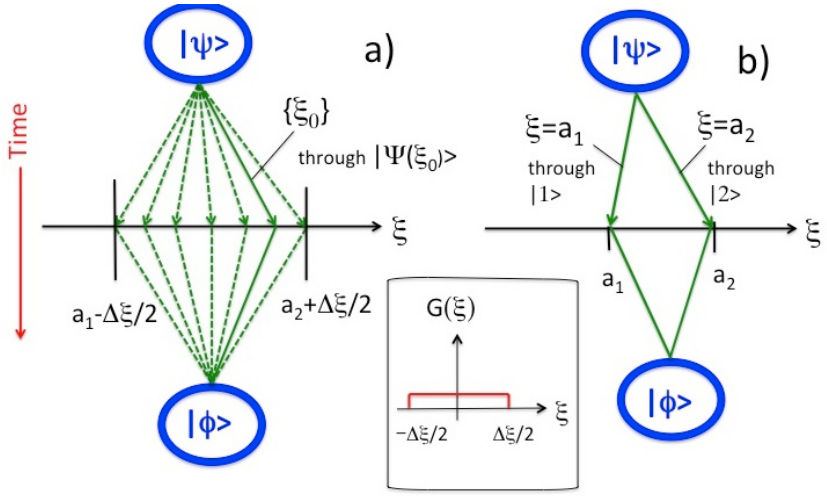
Figure 2. ( a ) Schematic diagram showing a continuum of real pathways produced in a measurement of an operator ˆ A with eigenvalues a 1 < a 2 . A pathway connects three observable events: preparation in | ψ (cid:105) at t = 0, obtaining a meter reading ξ 0 at t = T /2 and finding the system in | φ (cid:105) at t = T . If a reading ξ 0 is obtained, the system “passes” through the state | Ψ ( ξ 0 ) (cid:105) in Equation (14). For G ( ξ ) in Equation (13) (see the inset), the pointer readings are contained in the interval [ a 1 − ∆ ξ /2, a 2 + ∆ ξ /2 ] ; ( b ) The two real pathways surviving in the high accuracy limit, ∆ ξ →